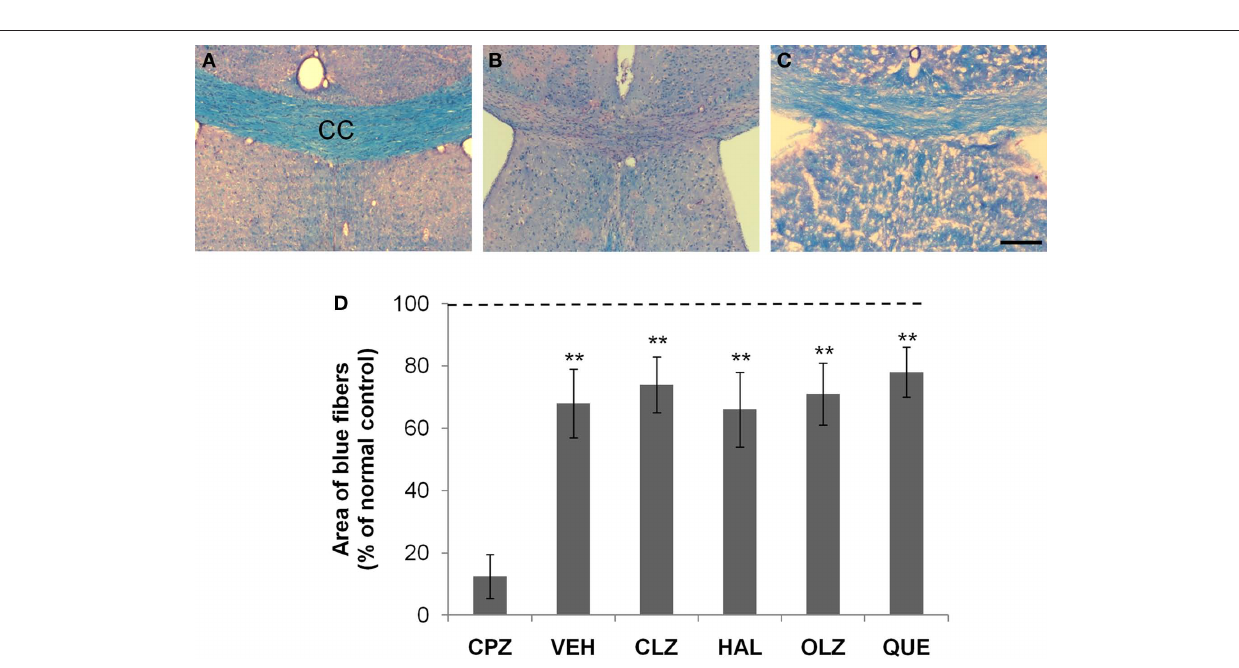
treated with VEH during the 3-week recovery period after CPZ withdrawal. (D) The quantitative data (mean ± SEM; n = 5/group). The dotted line indicates the value of the CNT group, which was significantly higher than all other groups. ** p < 0.01, compared to the CPZ group. The scale bar in the image (C) represents about 250